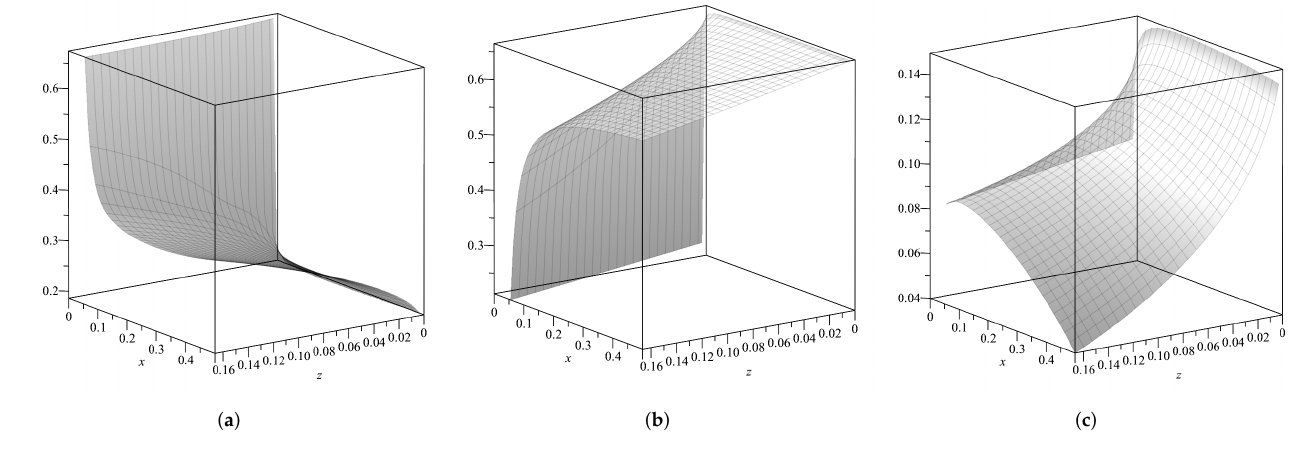
Figure 6. Graphs of p 1 , p 2 , p 3 as functions of x and z . ( a ) p 1 , ( b ) p 2 , ( c ) p 3